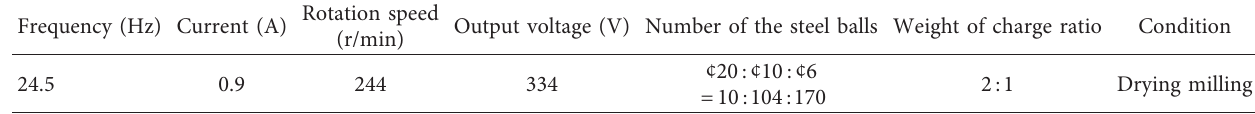
Table 1: The parameters of the ball milling